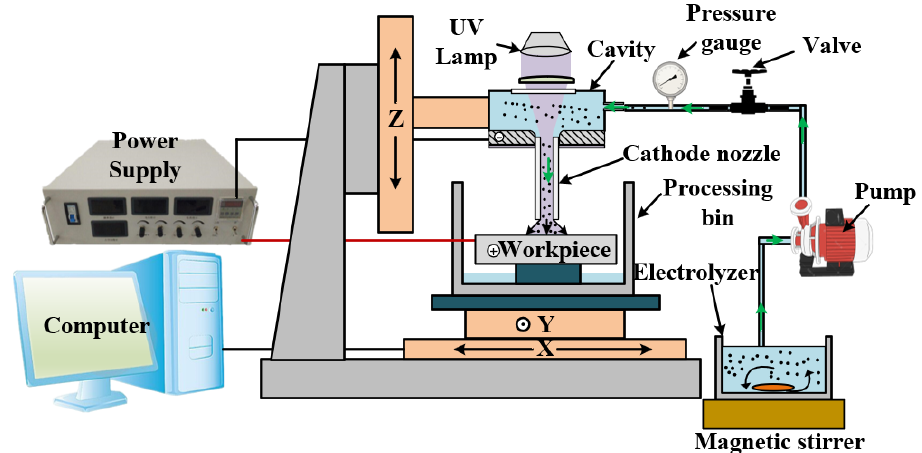
Figure 3. Schematic diagram of the PAJECM experimental setup.